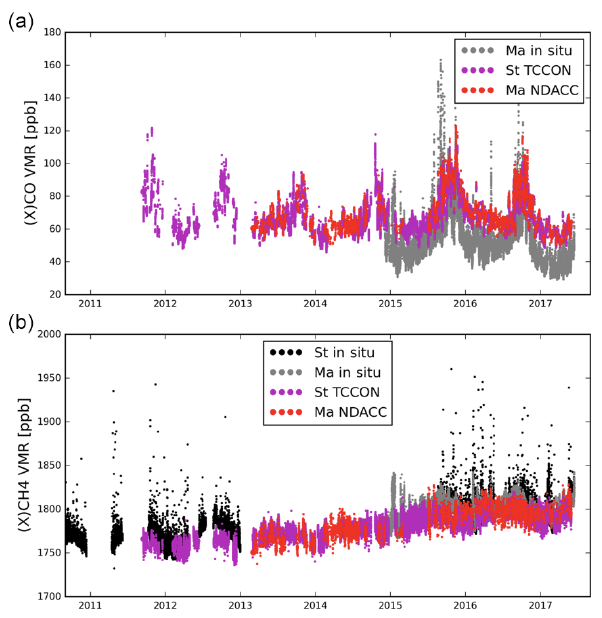
Figure 4. The time series of CO (a) and CH 4 (b) from in situ and FTIR (NDACC and TCCON) measurements at St Denis and Maïdo. Note that there is no CO in situ measurement at St Denis. “St” and “Ma” in the legend represent St Denis and Maïdo, respectively. “(X)gas” is used in the y axes labels to present in situ VMR mea- surements and FTIR X gas retrievals